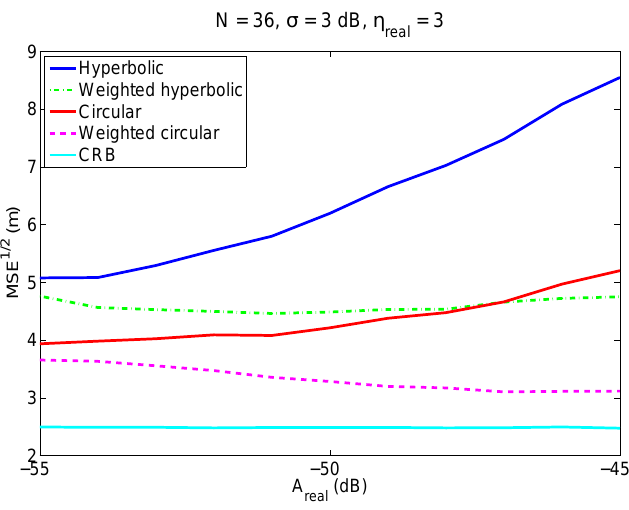
Figure 2. Average localization error (calculated as the square root of the MSE) of the four positioning methods as a function of A , for an environment with N = 36 and σ = 3 dB. real The Cramer–Rao bound is shown as comparison. The values of n corresponding to these values of A vary between 3.9 and real